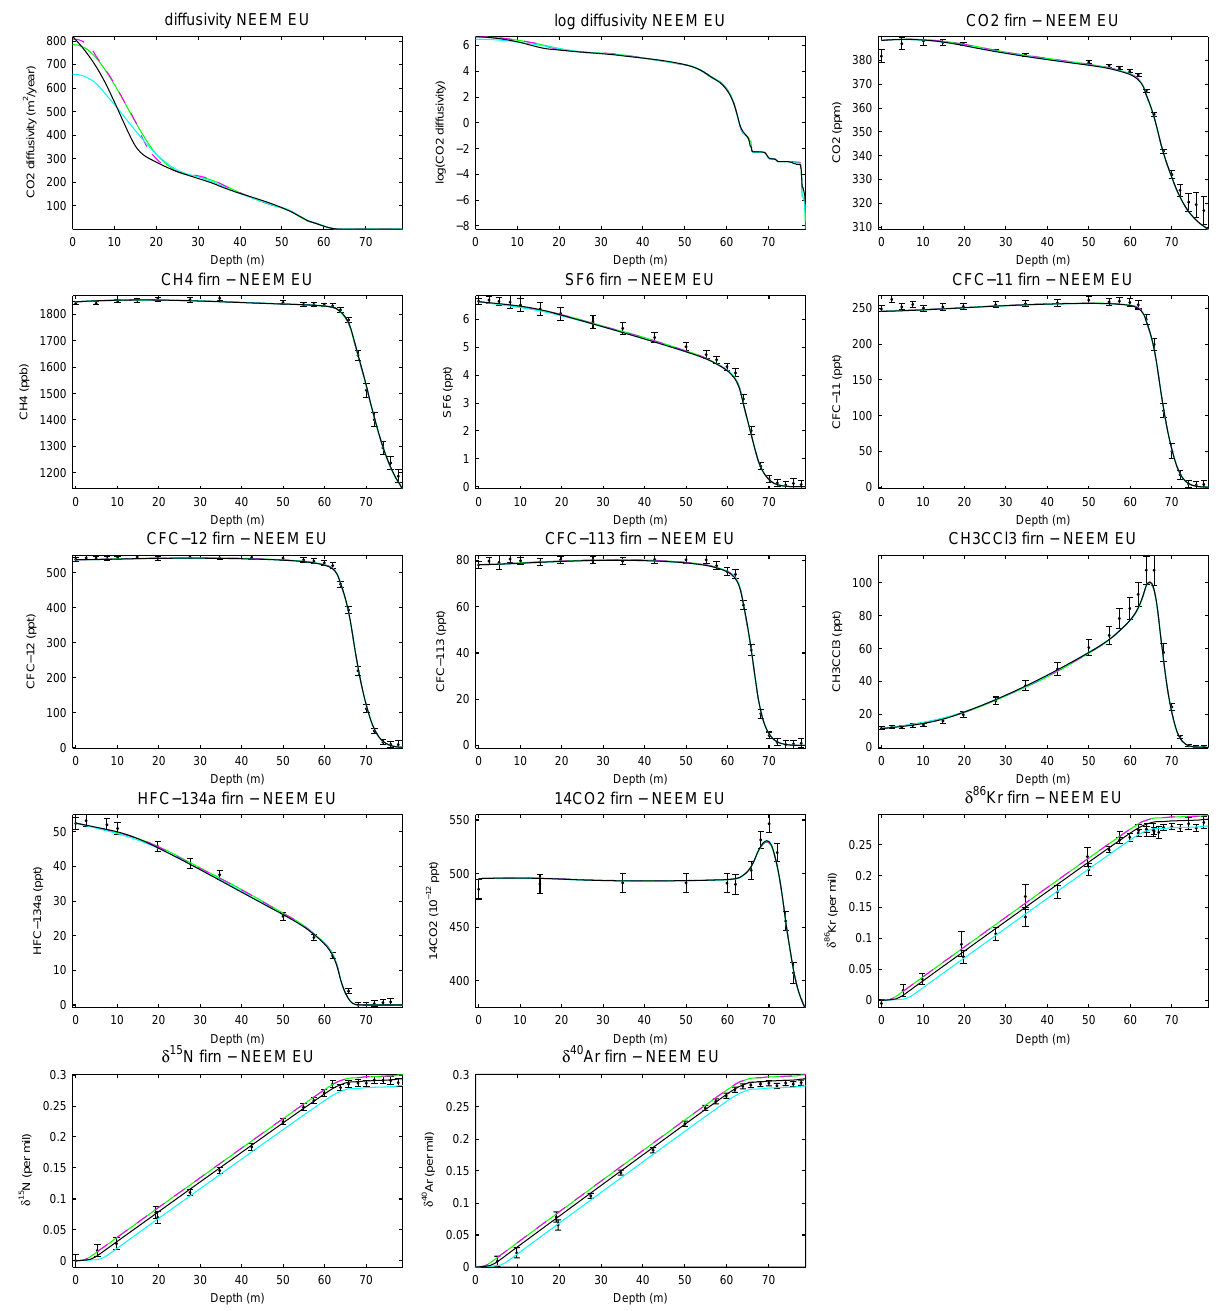
Fig. 1. Impact of the transport specification on the model results at NEEM (EU hole): with convective layer z conv = 4 m ( case 1, green), z conv = 4 m and a maximum molecular diffusivity set by the one in free air ( case 2, pink “- - -”), z conv = z eddy and a maximum molecular diffusivity set by the one in free air ( case 3, turquoise), z conv = 4m and a maximum molecular diffusivity corrected with the porosity ( case 4, black, reference case). The NEEM firn air datasets (dots) are described in Buizert et al. (2012) together with the uncertainty (vertical bars) evaluation, which include both measurement and scenario uncertainties. δ 15 N, δ 40 Ar, δ 86 Kr data were corrected for the effect of thermal